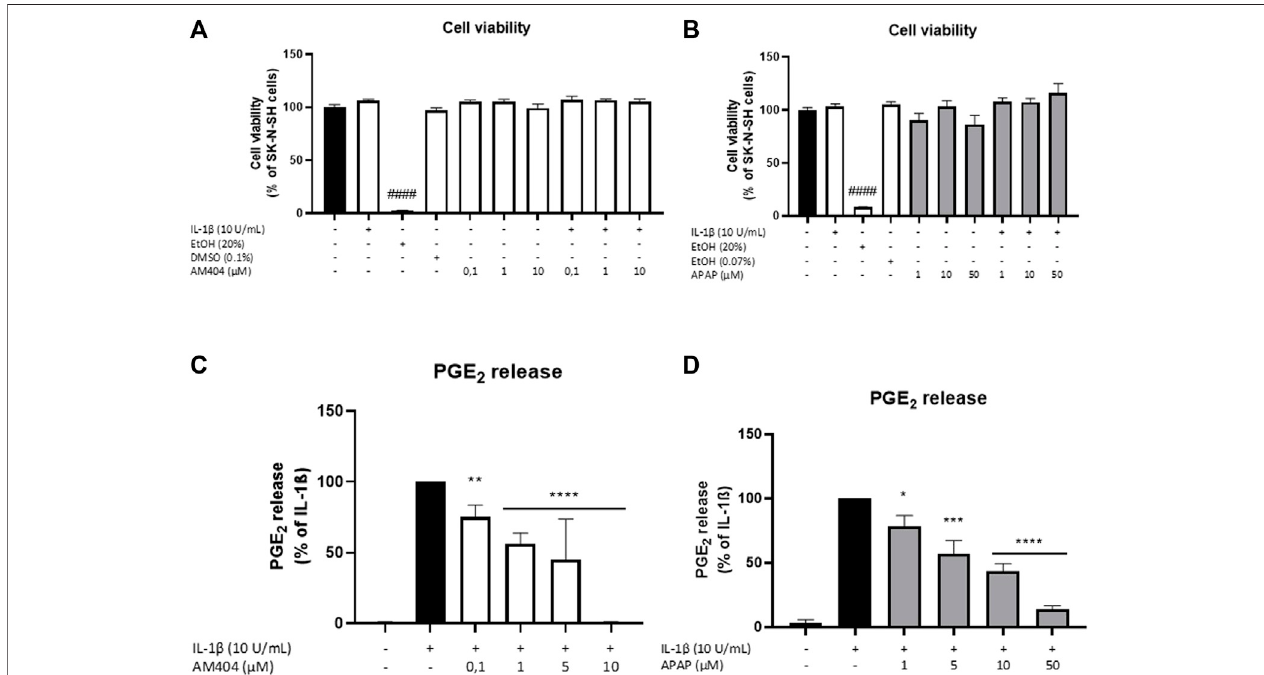
FIGURE 1 | Effects of AM404 (A,C) and acetaminophen (B,D) on cell viability (A,B) and PGE 2 release (C,D) of IL-1 β -stimulated SK-N-SH-cells (24 h treatment). Cells were stimulated as described under material and methods. (A,B) Cell viability was measured by change in color due to MTT-oxidation and absorbance was measured at 595 nm using an ELISA-reader. (C,D) After 24 h of stimulation, supernatants were collected and release of PGE 2 was measured by EIA. Values are presentedasthemean ± SEMofatleastthreeindependentexperiments.Statisticalanalysiswasperformedusingone-wayANOVAwithDunett ’ sposthoctestwith ** p < 0.01, *** p < 0.001 and ####/**** p < 0.0001 compared to untreated cells (A,B) or IL-1 β (C,D)